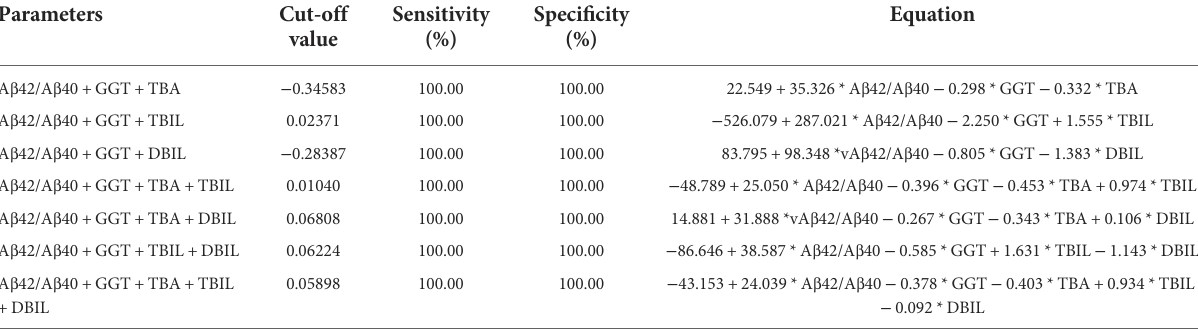
TABLE 5 Sensitivity and speci fi city of A β 42/A β 40 and γ -glutamyl transpeptidase in combinations with any one hepatic function parameters in the diagnosis of biliary atresia vs. non-biliary atresia cholestasis.